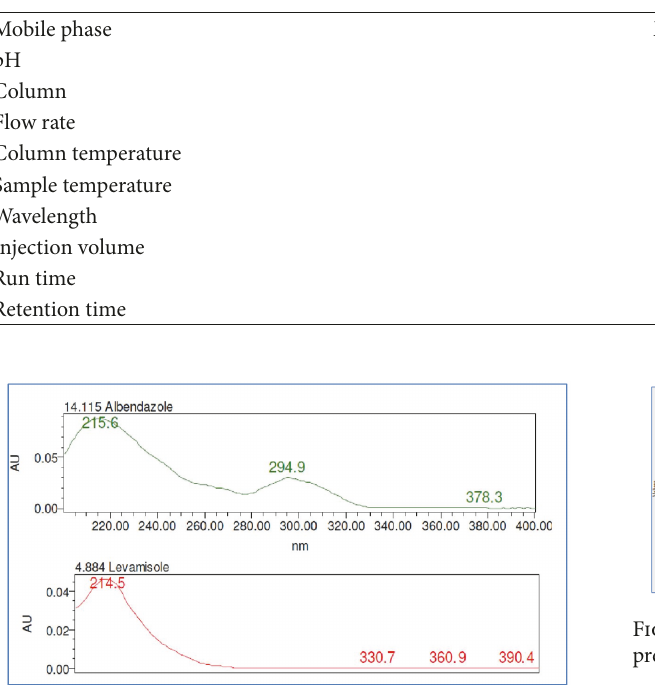
Table 1: Optimized chromatographic conditions.